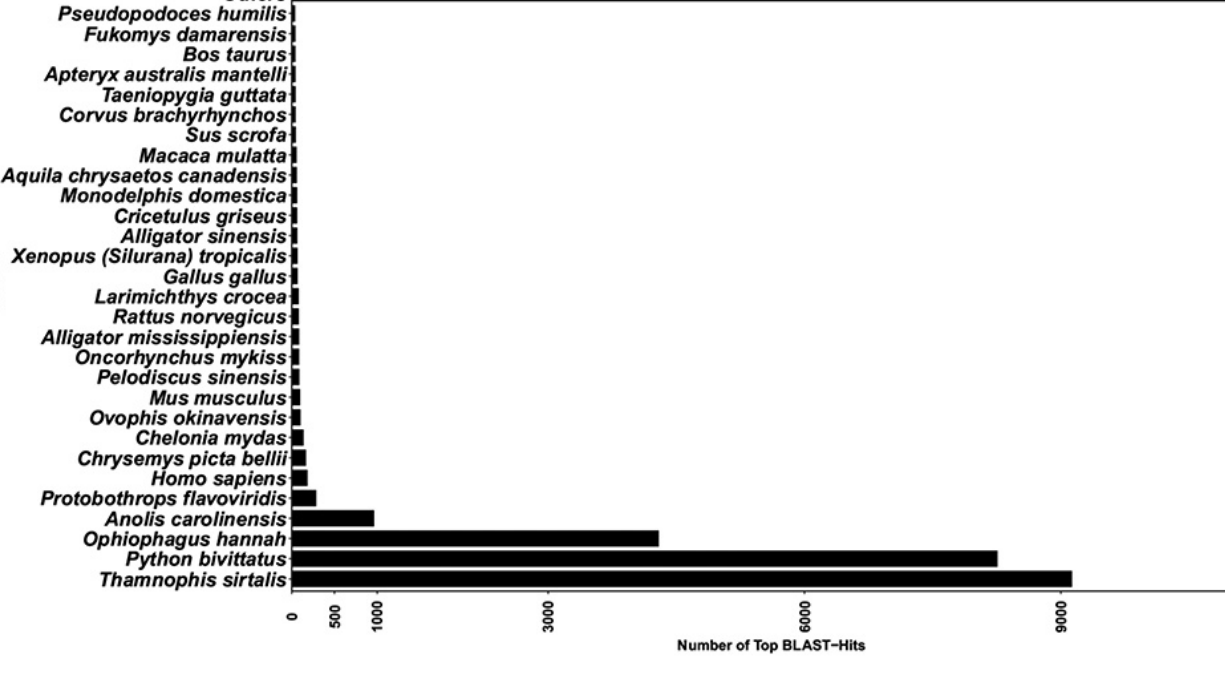
Figure 1. Top BLAST hit distribution of predicted proteins from of Bothrops jararaca venom gland transcriptome. Recovery by Blast2GO with similarity filter parameter of 55%, E-Value-Hit-Filter: 10 -6